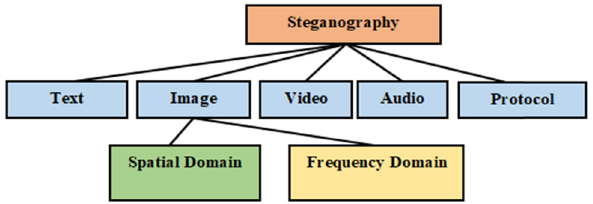
Figure 3: Steganography classi fi